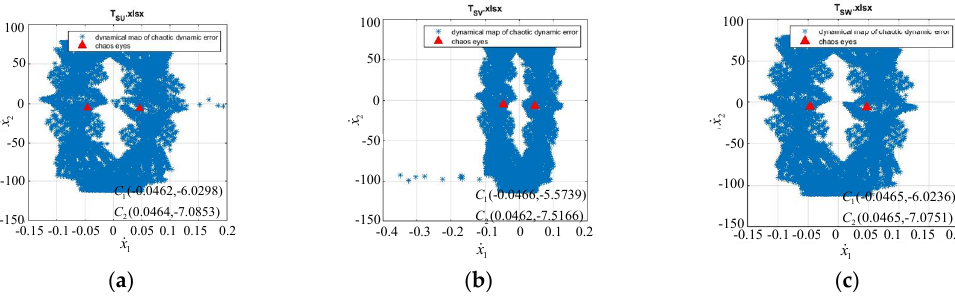
Figure 6. Chaotic scatter diagrams of each phase voltage of the inverter operating at 60 Hz and under normal switch operation: ( a ) Phase voltage v ao ; ( b ) phase voltage v bo ; ( c ) phase voltage v co .